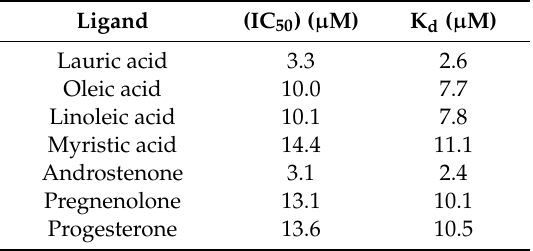
Figure 2. Competitive binding of selected fatty acids ( a ) and steroids ( b ) to rFel d 1. Fluorescence emission spectra were recorded at 25 °C in the presence of 1 µM of rFel d 1 and 2 µM of 1-NPN; excitation and emission wavelengths were 337 and 407 nm, respectively. Fluorescence of probe-protein complexes in the absence of a competitor was normalized to 100%. Table 2. A ffi nities of di ff erent ligands to rFel d 1, evaluated in competitive binding